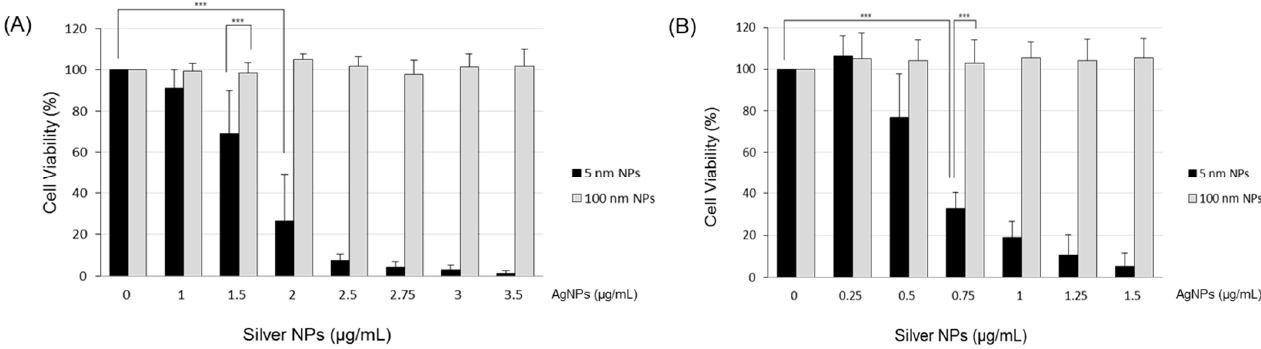
Figure 2. Cytotoxicity of silver NPs. The median lethal dose of 5 nm silver NPs was approximately ( A ) 1.72 µg/mL in EA.hy926 cells and ( B ) 0.65 µg/mL in BEAS-2B cells. Data represent the mean ± standard deviation of three independent